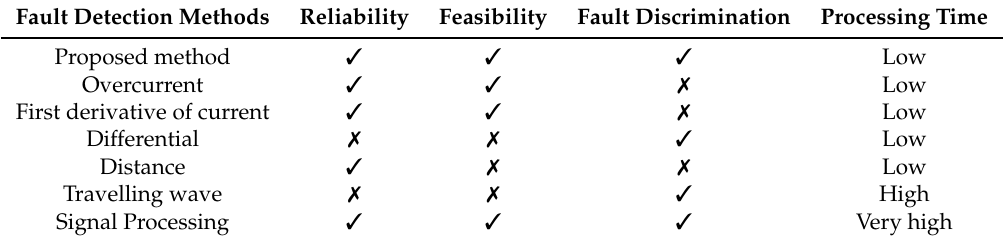
Table 3. Comparison of different fault detection methods for a last mile Low Voltage Direct Current (LVDC) distribution